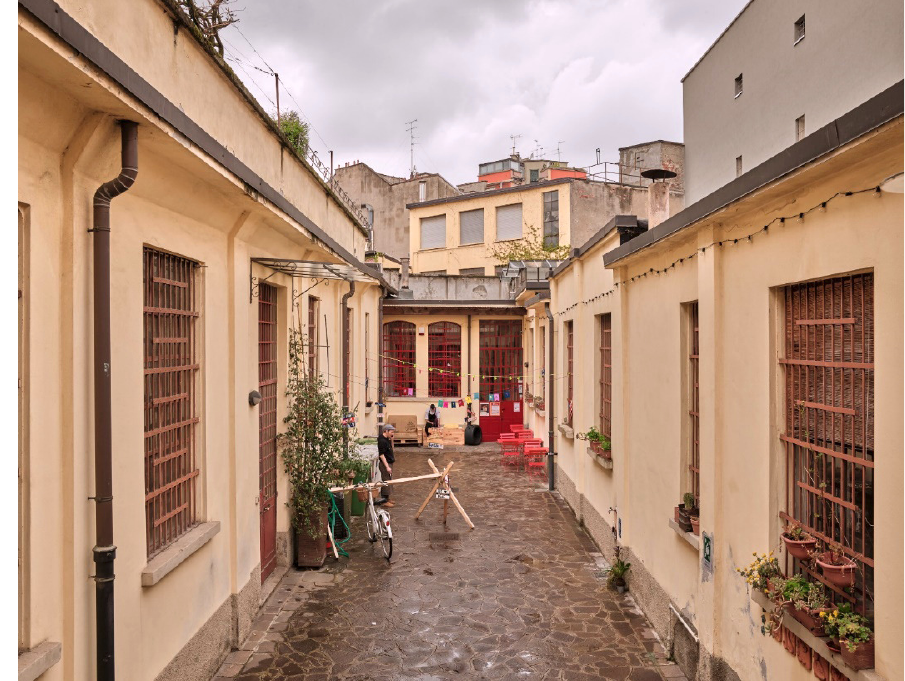
Figure 9. The courtyard whit the entrance of WeMi Venini/Hug Milano. Source: Courtesy of Giovanni